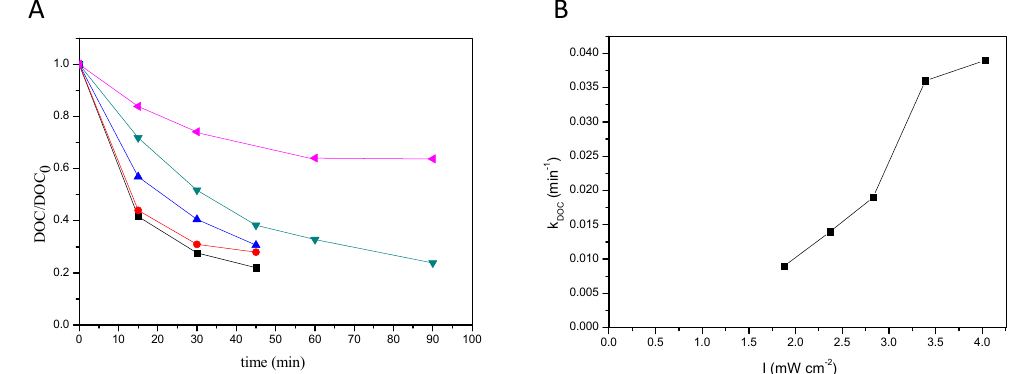
Figure 7. ( A ) Effect of incident UV-A radiation intensity on the mineralization of simulated wastewater containing 40 mg L − 1 CLPR in the presence of the photo-Fenton reagent (7 mg L − 1 Fe 3+ , 100 mg L − 1 H 2 O 2 , pH: 3.0): [ ■ ] I = 4.03 mW cm − 2 , [ ● ] I = 3.39 mW cm − 2 , [ ▲ ] I = 2.83 mW cm − 2 , [ ▼ ] I = 2.37 mW cm − 2 , [ ◄ ] I = 1.88 mW cm − 2 . Total volume: 15 L, illuminated volume: 5 L.; ( B ) effect of intensity of incident UV-A radiation on the reaction constant, k DOC .